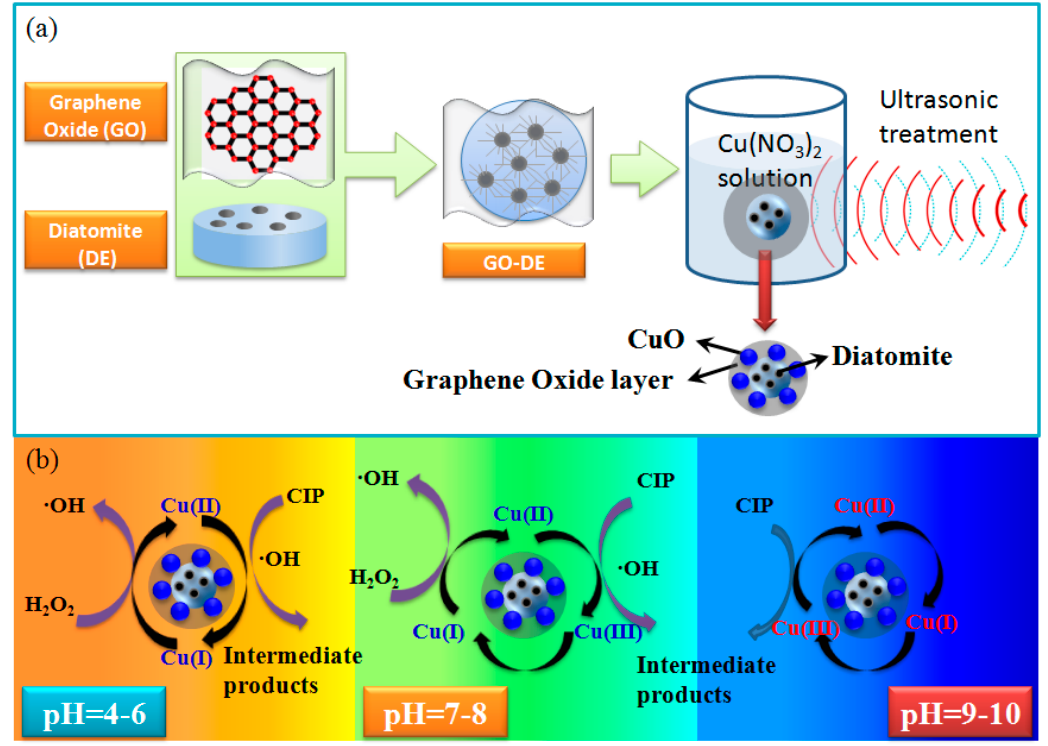
Figure 6. Preparation process of Cu/GO-DE ( a ) and degradation mechanism of CIP by Cu/GO-DE/H 2 O 2 in different pH ranges ( b ).